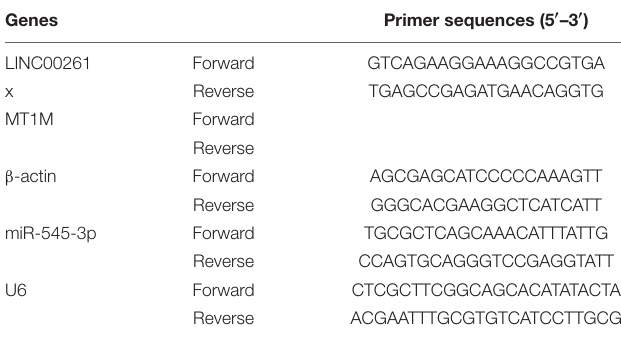
TABLE 1 | Primer sequences used for